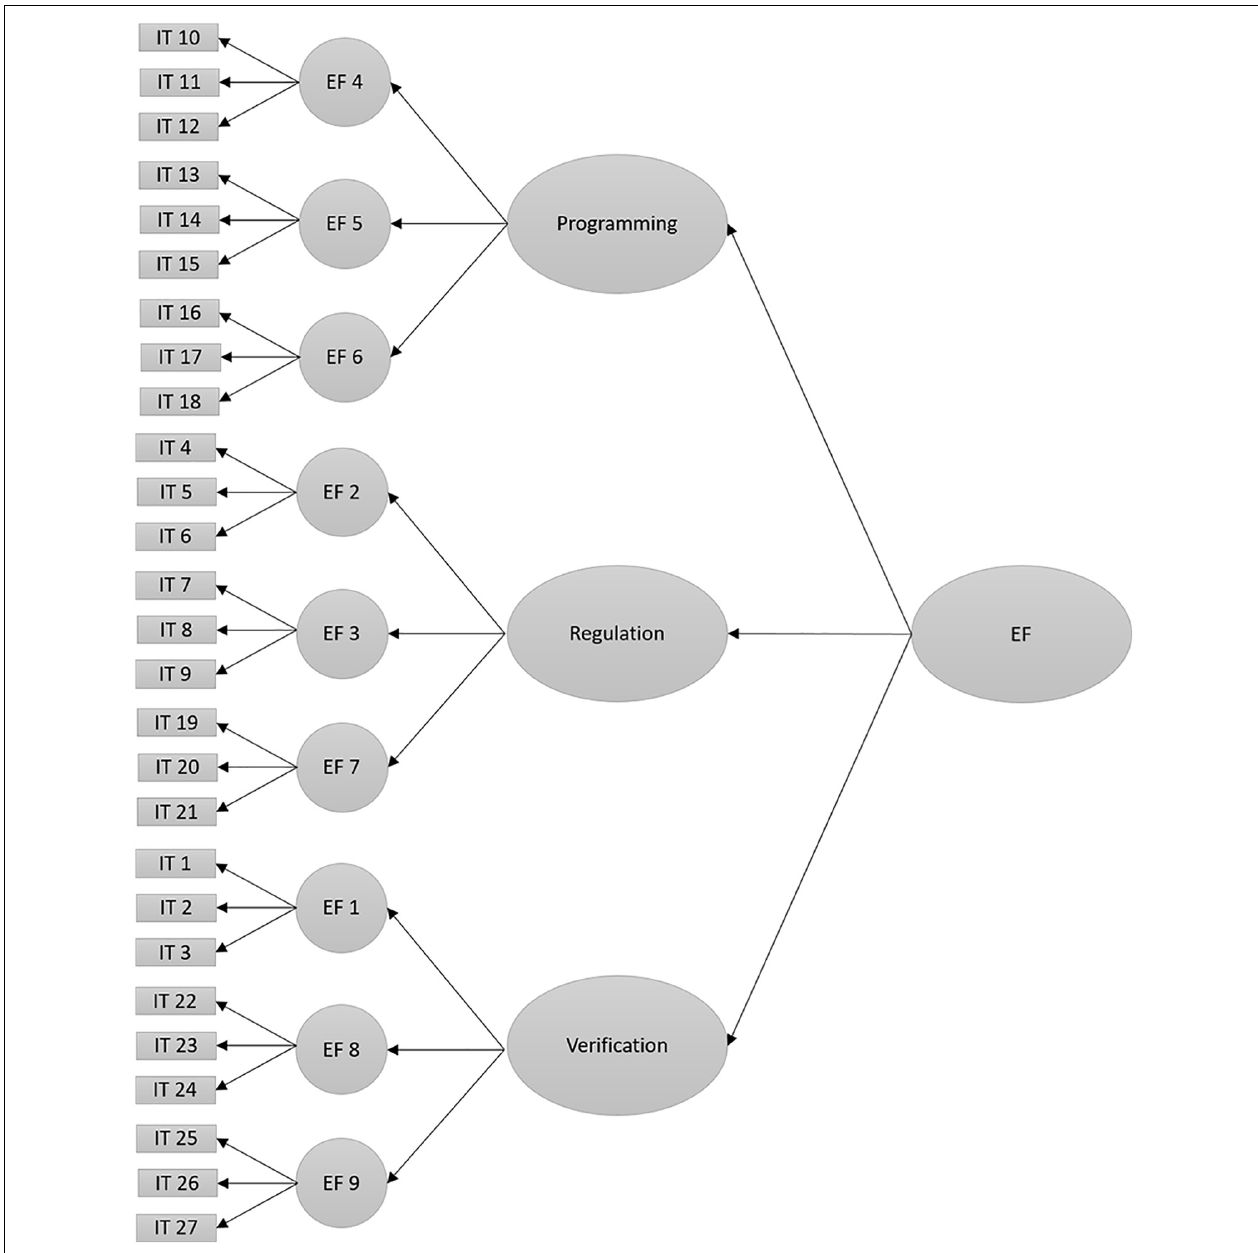
FIGURE 3 | Factorial model of one factor of third order and three factors of second order of the scale EOCL-1 (Model 3). Note: Acronyms are the same as in Figure 1 .